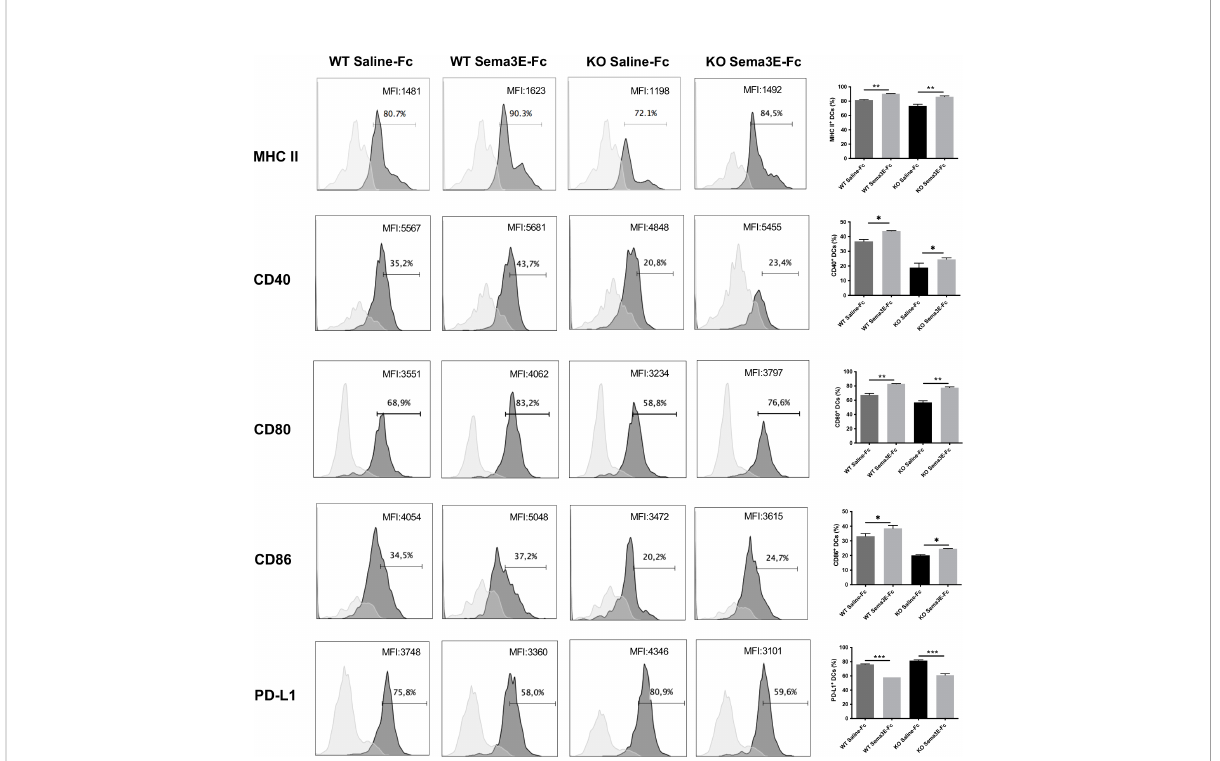
FIGURE 7 Sema3E treated mice showed the altered surface phenotype of DCs following Cm infection. Sema3E KO and WT mice were infected intranasally with Cm , treated with Sema3E-Fc, or saline-Fc, and sacri fi ced after 3 days. DCs were isolated from the lungs using CD11c microbeads, and cells were stained for surface markers and analyzed using fl ow cytometry. Expression of CD40, CD80, CD86 and PDL-1 on CD11c + MHCII + cells (dark shaded histograms) and isotype control (light shaded histograms) were shown. MHCII expression on CD11c + cells and isotype control were recorded. The percentages and mean fl uorescence intensity (MFI) of positive cells were indicated. One of the two independent experiments with similar results is shown (n = 3). * p < 0.05, ** p < 0.01, *** p <